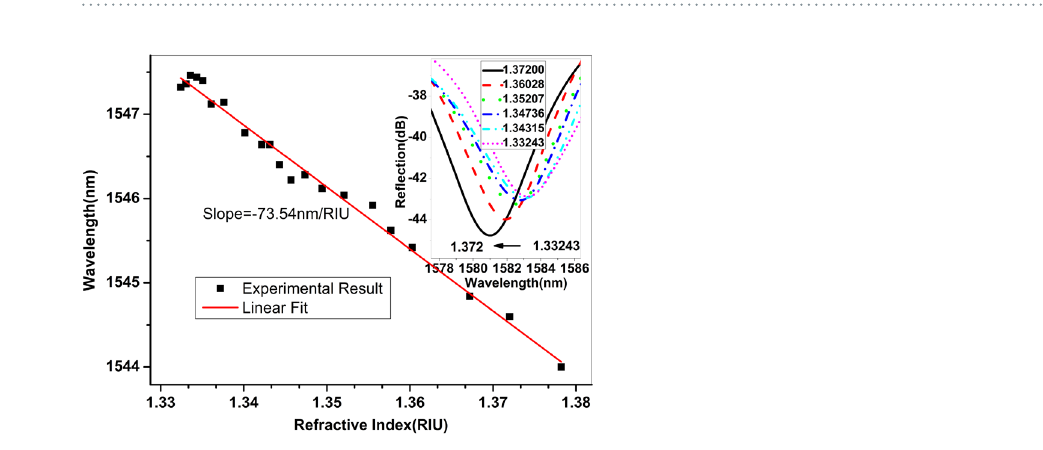
Figure 7. Fringe dip wavelength shift with the temperature variation. Inset shows the reflection spectra of the device at different temperatures.